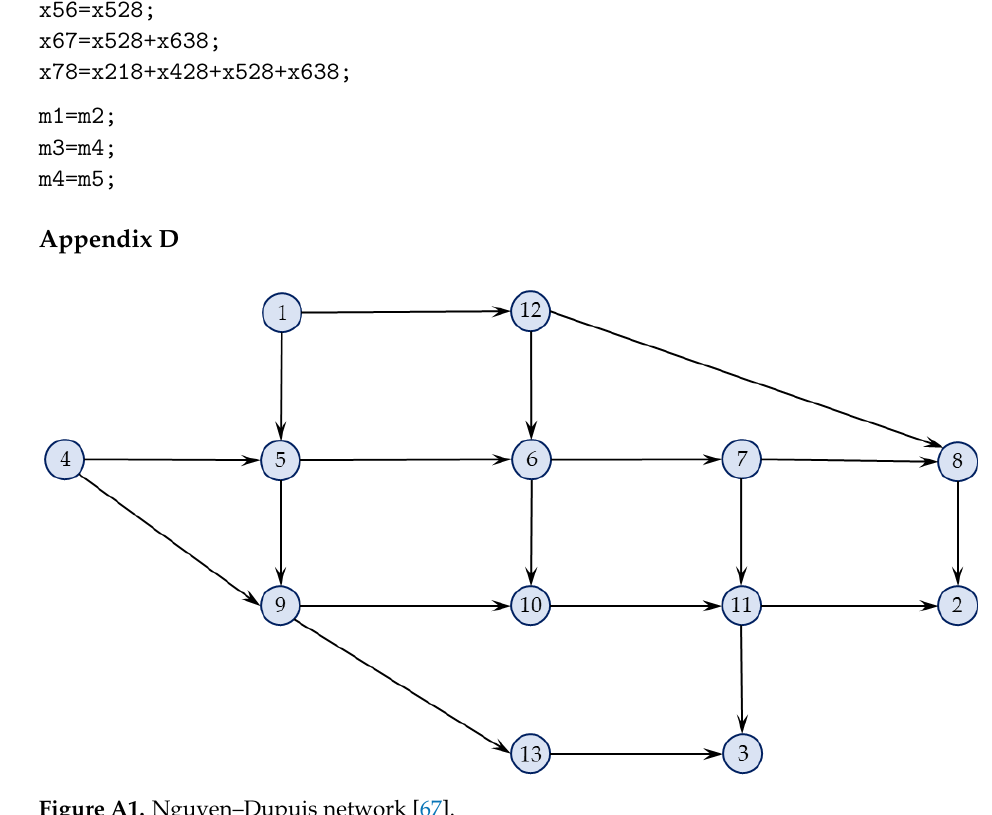
Figure A1. Nguyen–Dupuis network